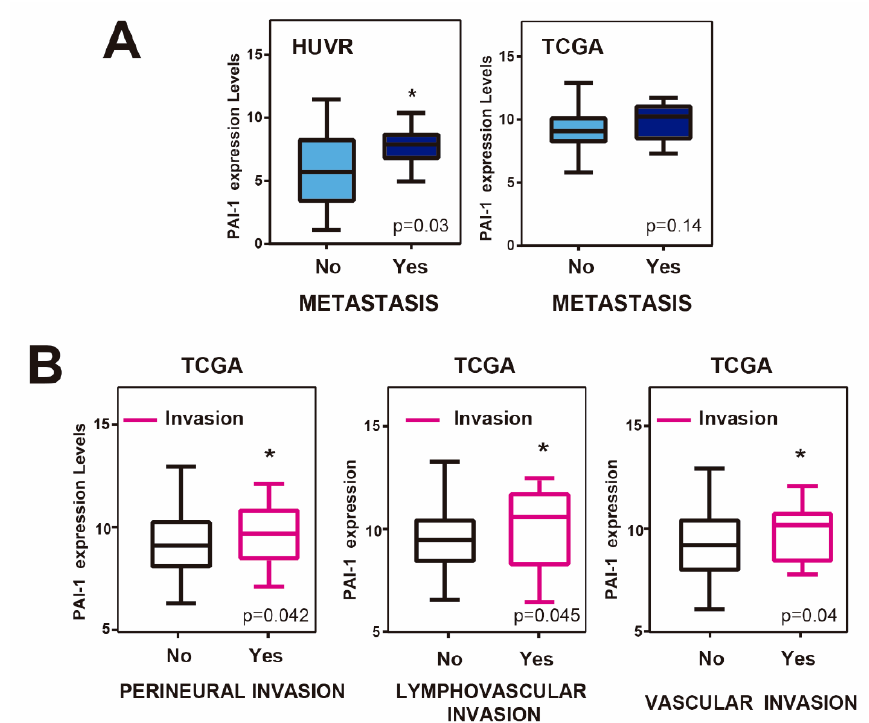
Figure 3. PAI-1 expression, invasion and metastasis in rectal cancer patients. ( A ) PAI1 expression levels in samples of patients with (YES) or without (NO) metastasis in our own cohort from HUVR-IBIS and the TCGA rectal cancer patient database. ( B ) PAI1 expression levels in samples of patients with (YES) or without (NO) perineural, lymphovascular or vascular invasion from the TCGA rectal cancer patient database. Student’s t -test. * p < 0.05.